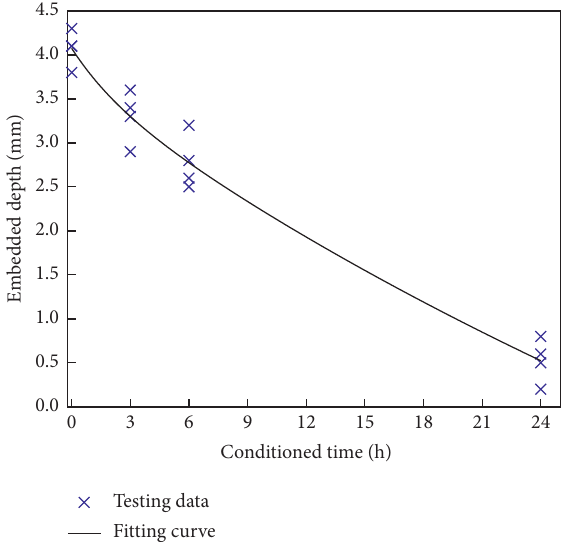
Figure 11: Variation of embedding depth with curing time.